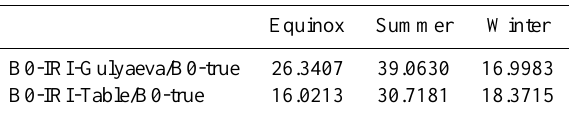
Table 2. The rms deviation between modeled and observed values during three